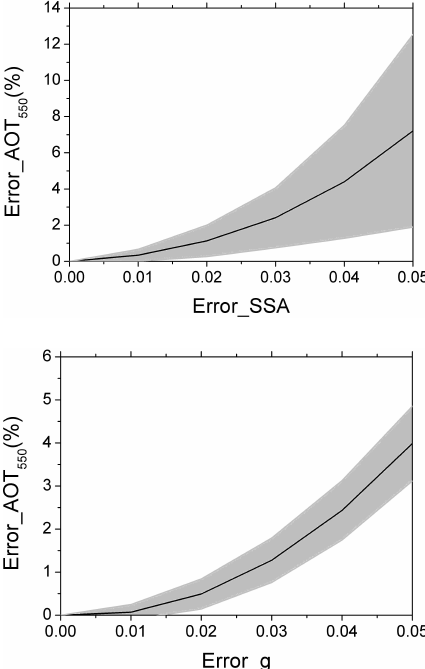
Fig. 3. Percent errors of the retrieved AOT as a function of the error within ± 0.05 for SSA and ± 0.05 for g (geometrical inputs are θ 0 =60 ◦ , θ S =0 ◦ , and ϕ =0 ◦ ). The shaded area shows ± σ . The valid range of AOT 550 is 0–5.